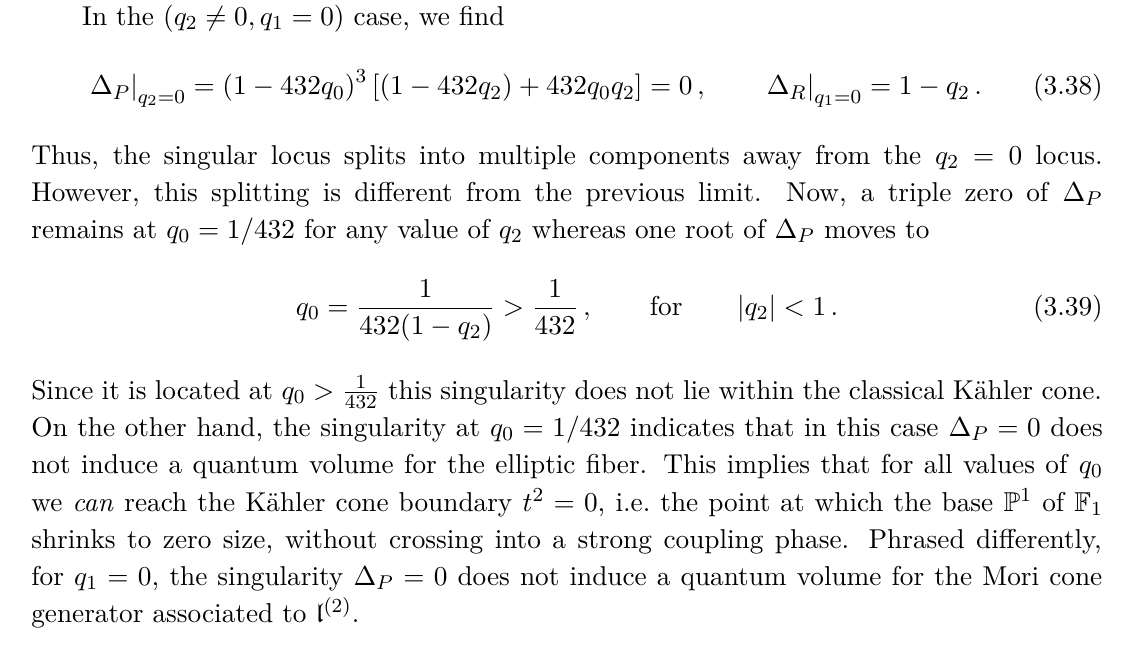
, of the GLSM FI- i = 0 } -plane, R = log432 . 0 2 π and ∆ P R